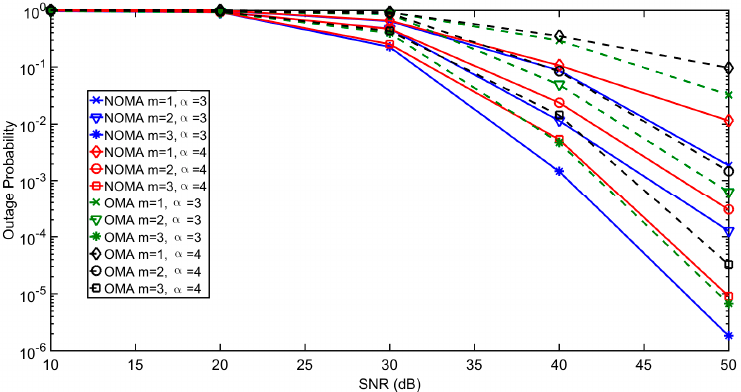
Figure 4. Impact of α on outage probability of each m -th user.